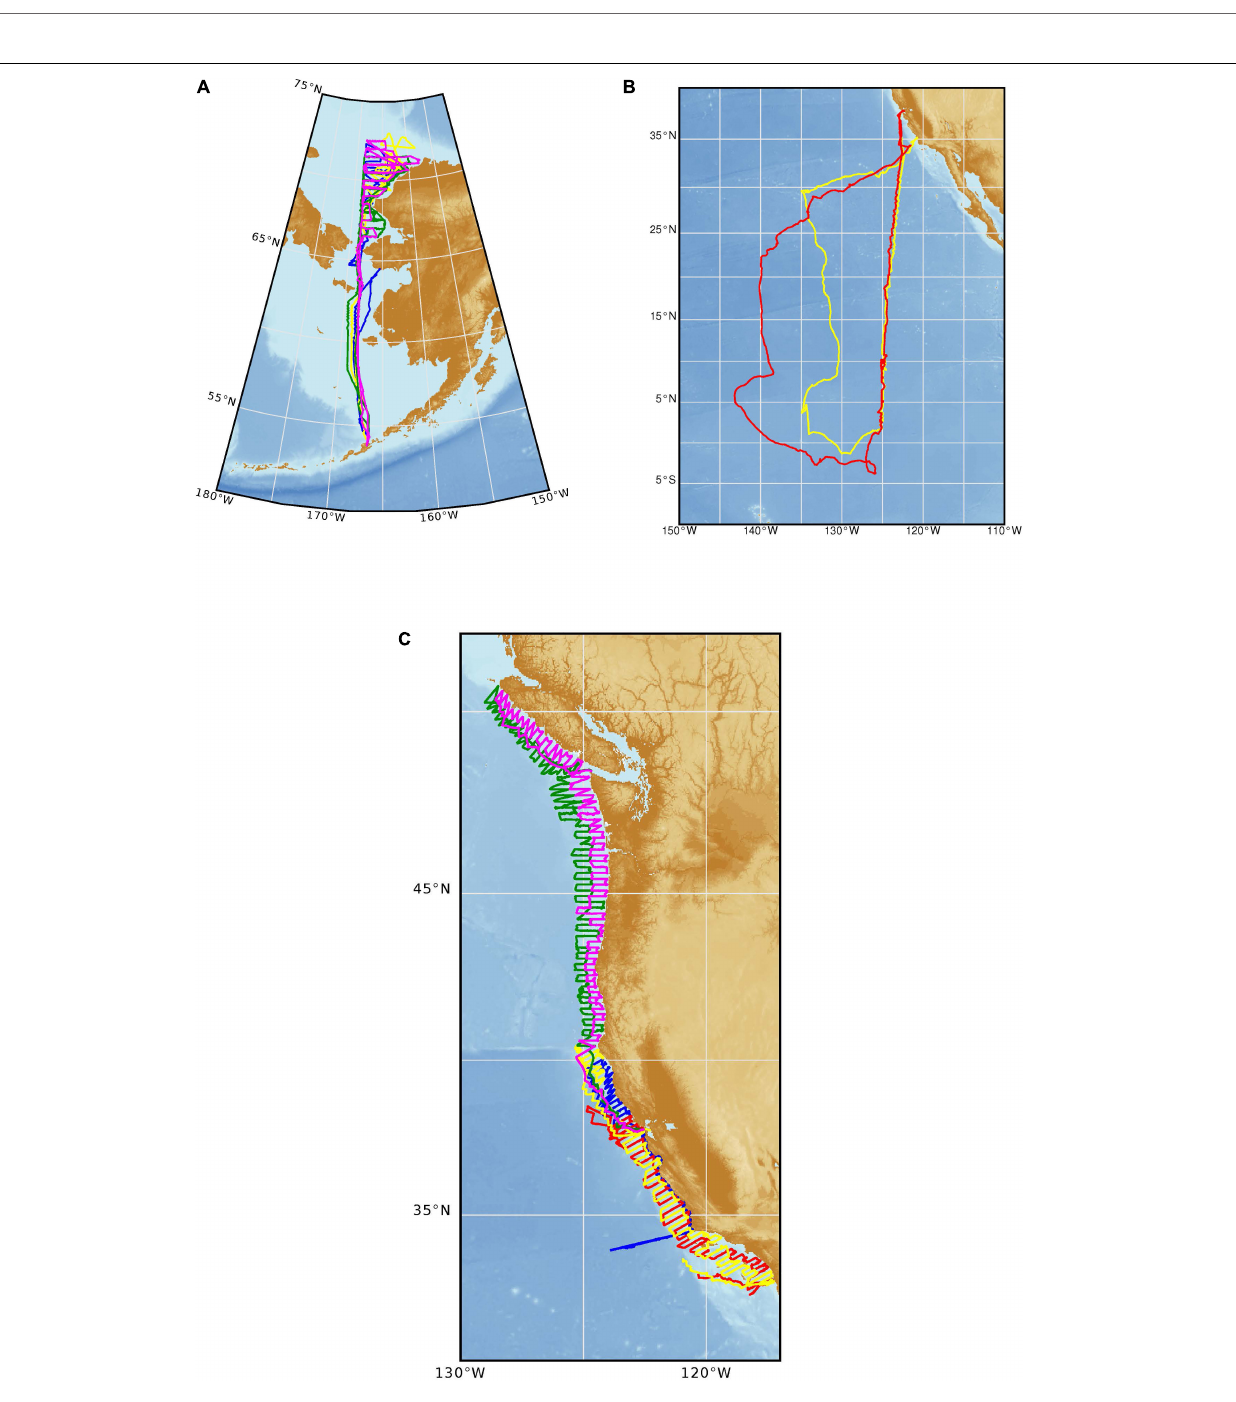
FIGURE 3 | Saildrone USV tracks from (A) four vehicles during a four-month mission in the Bering and Chukchi Seas in 2018, (B) two vehicles during a ∼ nine-month equatorial mission in 2017–2018, and (C) five vehicles during a four-month fisheries mission on the North American West